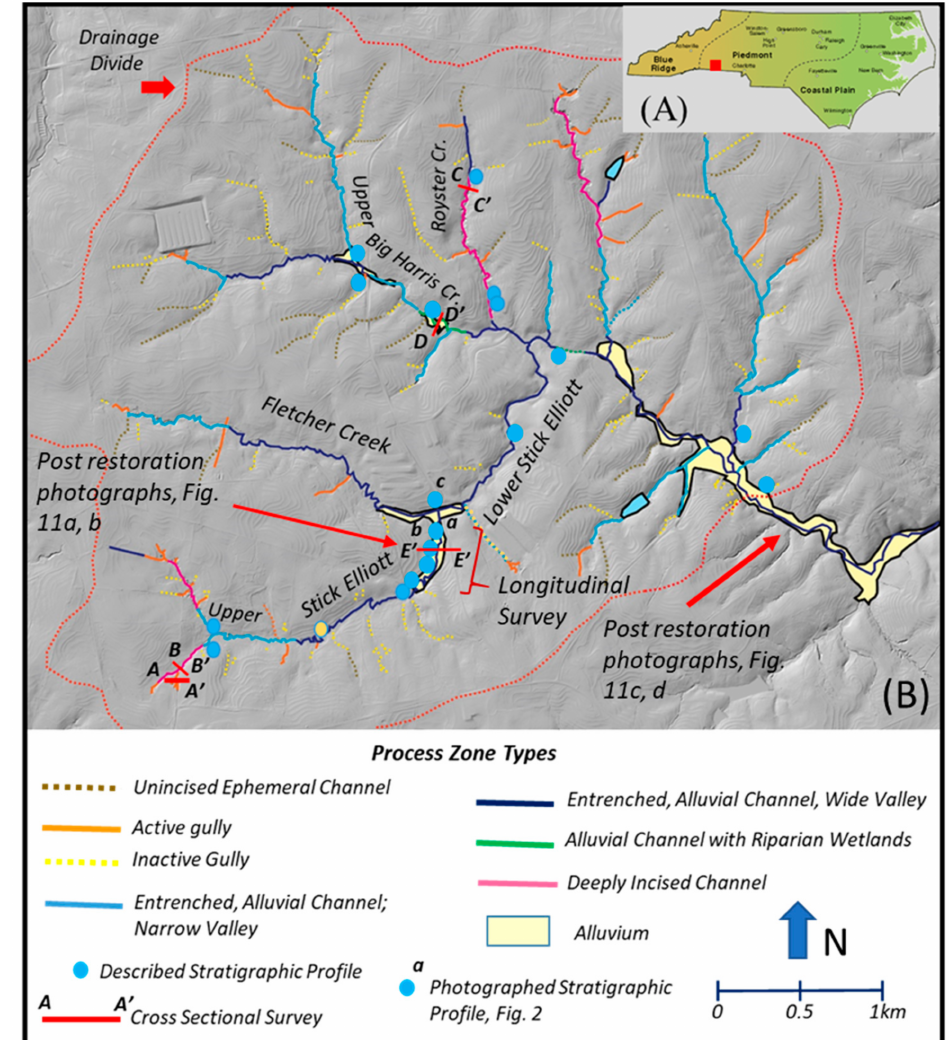
Figure 1. ( A ) Map showing the location of the Big Harris Creek basin in North Carolina; ( B ) Spatial distribution of the seven defined process zones within the basin and the location of the described stratigraphic sections. Mapped areas of alluvium characterized by legacy sediments overlying precolonial deposits. North Carolina map from the USGS. LiDAR DEM from the North Carolina Spatial Data Download Center (https://sdd.nc.gov/, accessed on 10 October 2021). See Table 1 for process zone characteristics. Figure S1 and Table S1 provide the location and descriptions of specific stratigraphic